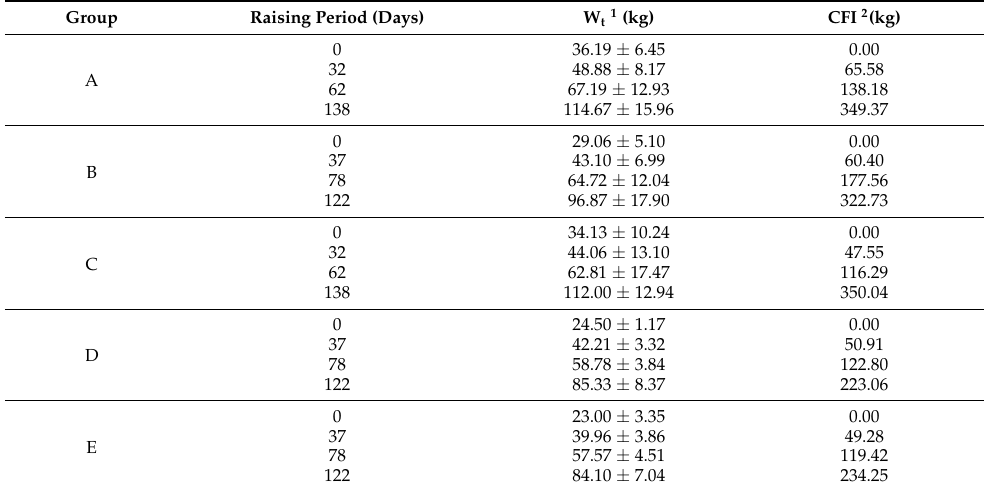
Table 2. Raw data of weight (Wt) and cumulative feed consumption (CFI).